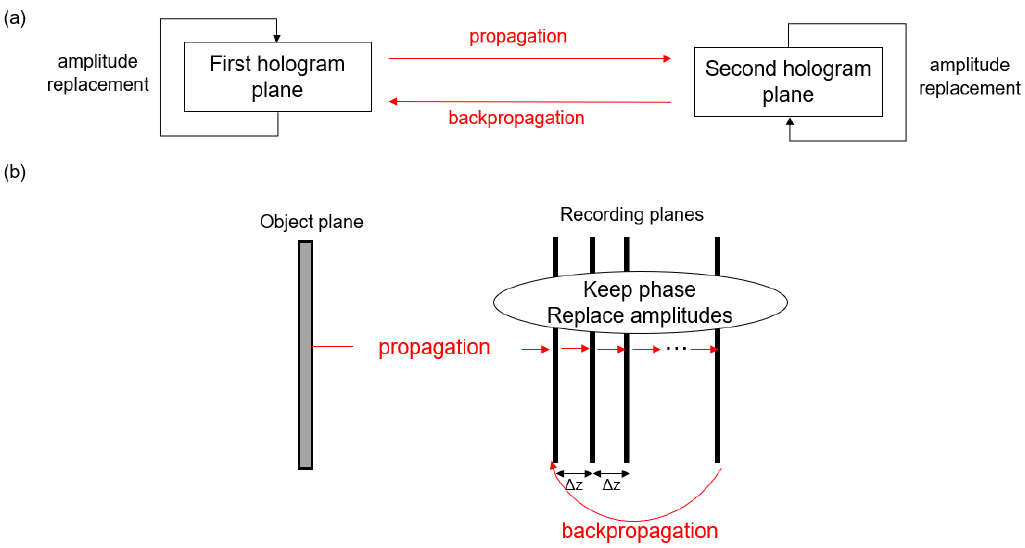
Figure 3. Diagram of iterative phase recovery algorithm. ( a ) Gerchberg–Saxton iterative phase retrieval. ( b ) Multi-height iterative phase retrieval.